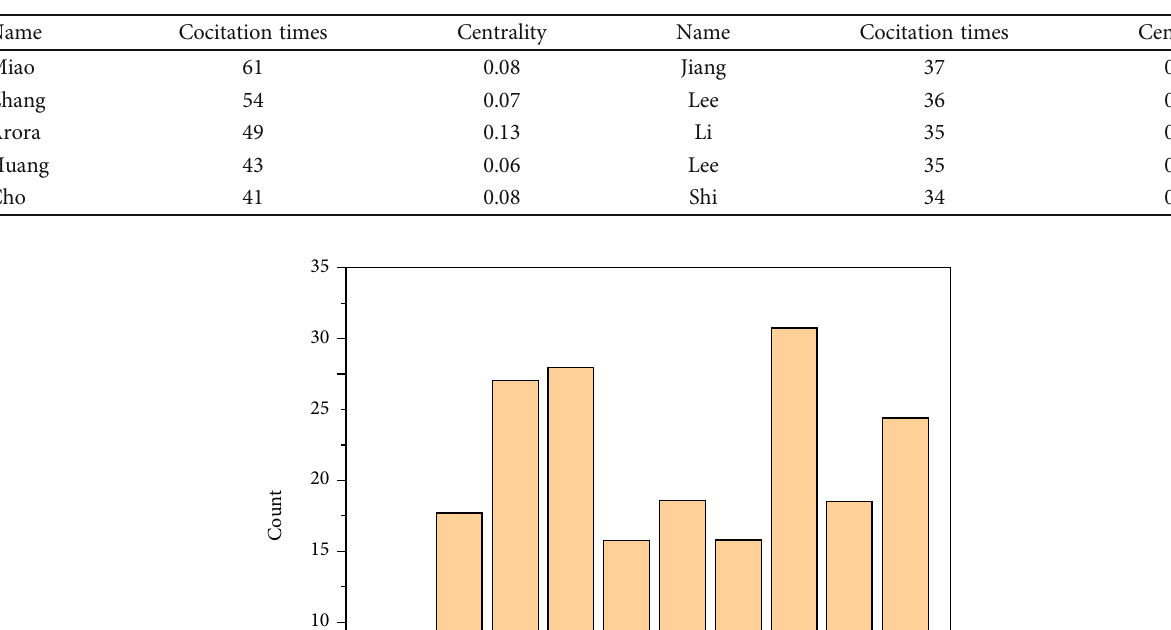
Table 3: Top ten authors with the highest cocitation times.